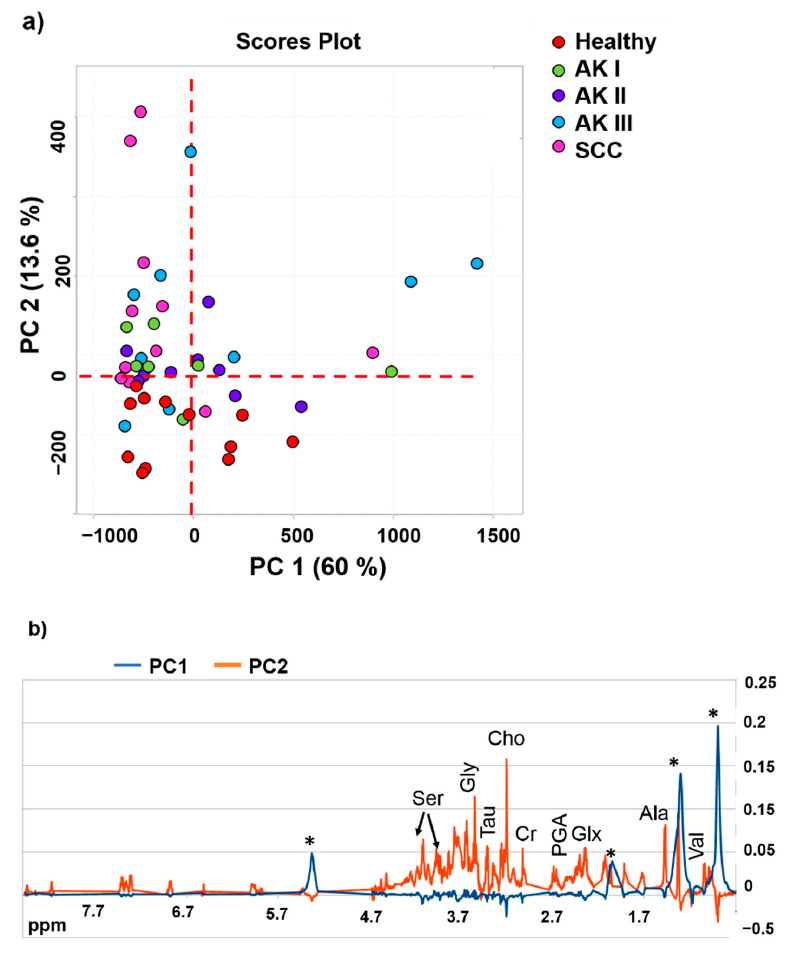
Figure 2. ( a ) PCA scores plot and ( b ) loadings profiles of PC1 and PC2 obtained from the spectral CPMG data of the five classes of samples. Legend: *—lipids residues, Val—valine, Ala—alanine, Glx—glutamate and glutamine, PGA—pyroglutamic acid, Cr—creatine, Cho—choline, Tau—taurine, Gly—glycine,